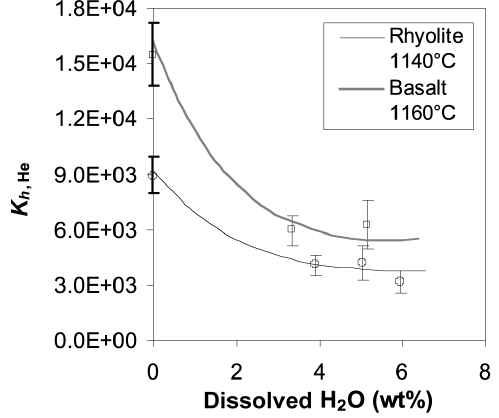
Fig. 8. Effect of dissolved water concentration on the helium Henry’s constant, the latter expressed in MPa and calculated on 8-oxygen basis melt (modi- fied from Nuccio and Paonita, 2000). Experimental data (symbols) from Paonita et al . (2000) were ob- in the range 100- tained in the condition P tot ≈ P H 2 O 200 MPa, and about 0.1 mol% He in the vapor. Curves were computed by using the model by Nuc- cio and Paonita (2000), which accounts for the effect of H 2 O and CO 2 on both noble gas solubility in melt and fugacity in vapor (see